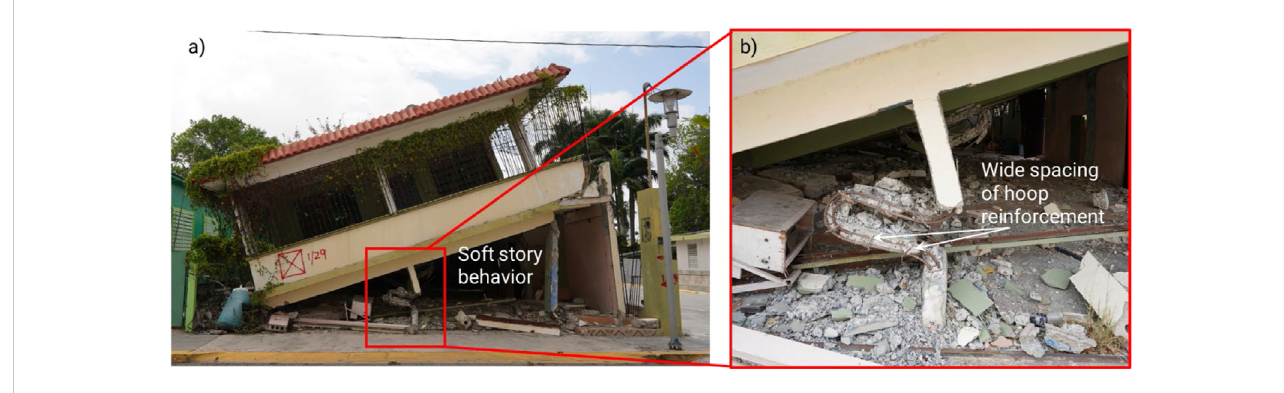
FIGURE 10 Damage of building in Guánica, PR following earthquake series showing (A) overall damage and soft-story failure mode and (B) close up of support column